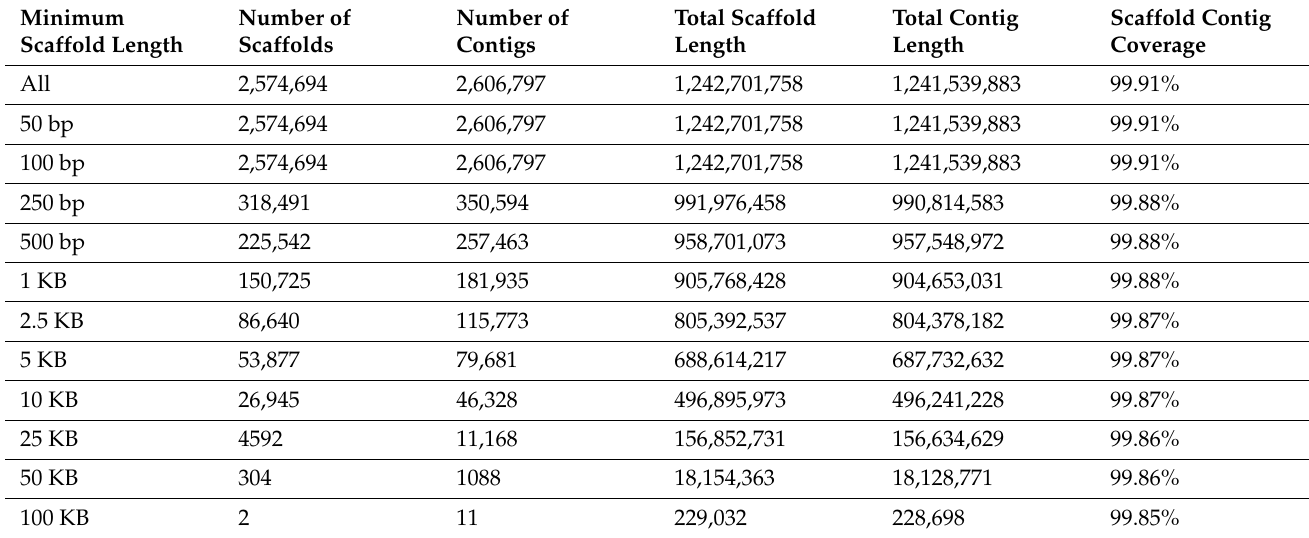
Table 2. Assembly statistics for Platanus after the three steps of contig assembly, scaffolding, and gap-closing. Parameters: k-mer 96, step size default, bubble crush default (0.1), min coverage default (2). Main genome scaffold N/L50: 42,216/6.641 KB. Main genome contig: N/L50 54,953/5.258 KB. Main genome scaffold: N/L90 1,432,405/105. Main genome contig: N/L90 1,464,507/105. Max scaffold length: 126.758 KB. Max contig length: 79.472 KB. Number of scaffolds > 50 KB: 304.